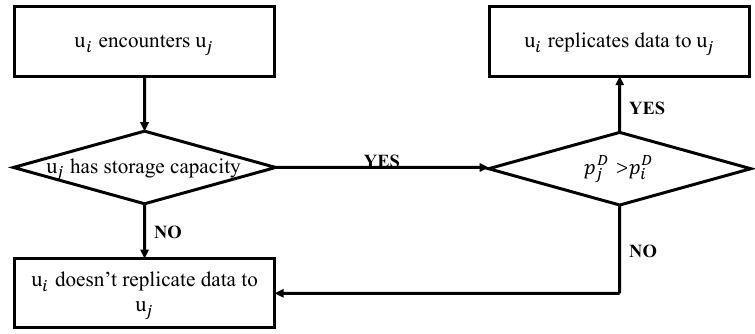
Figure 3. Data forwarding selection in sub-process